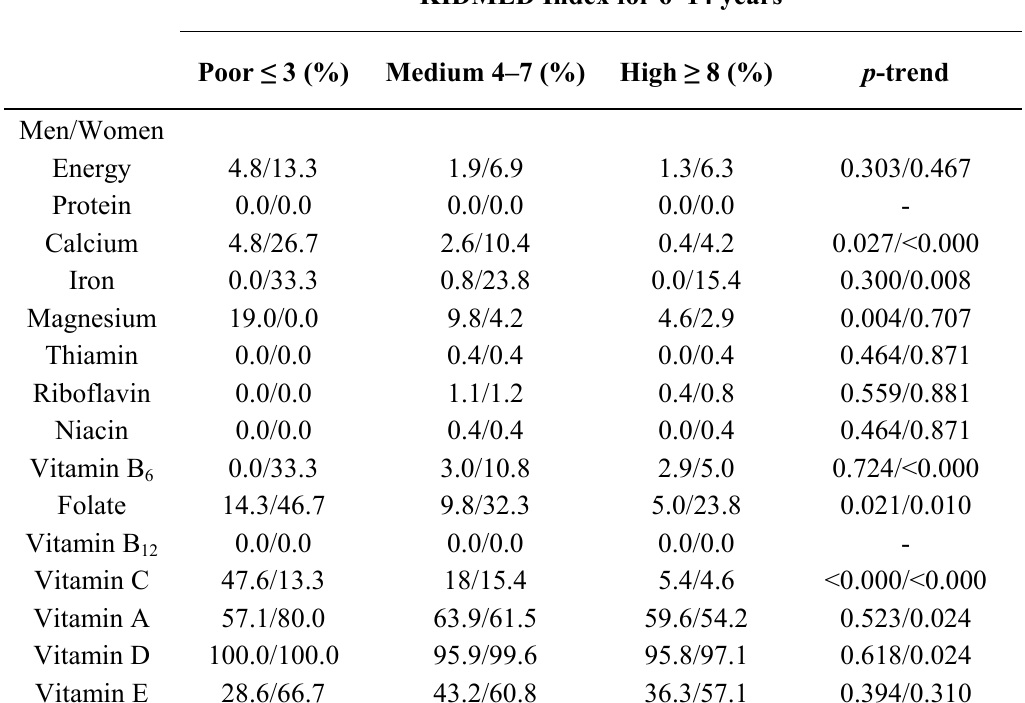
Table 3. Percentage of inadequate intakes (<2/3 INL) in scholar children according to Mediterranean Diet adherence